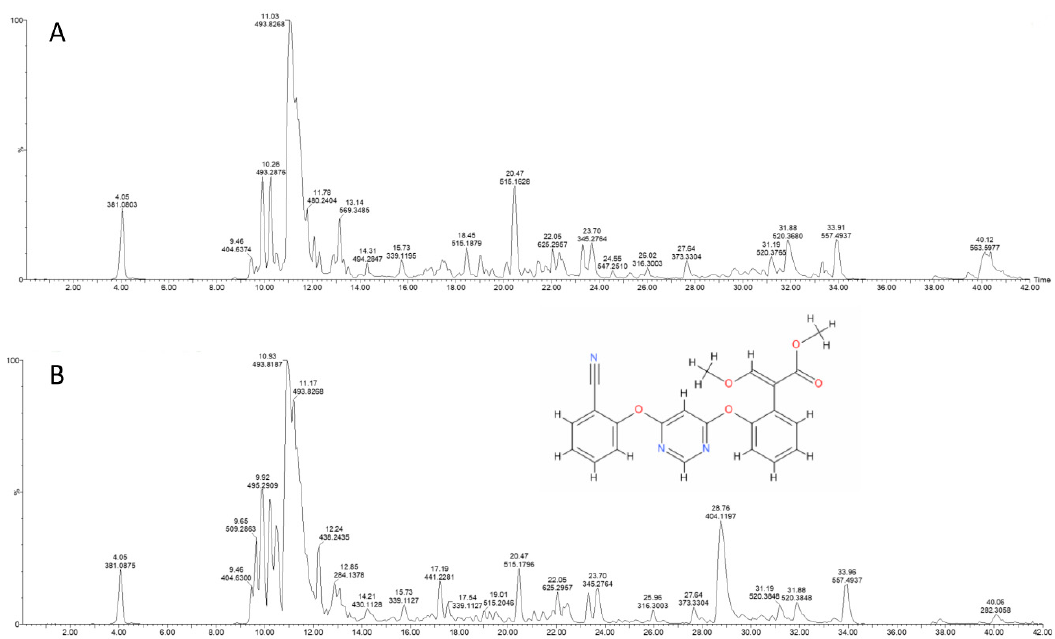
Figure 1. Q-TOF survey profile of the total metabolites extracted from maize root in control (panel A ) and azoxystrobin treated ones (Panel B ). Untargeted MS of roots methanol extracts at 96h has revealed the presence of a differential peak occurring at about 28.5 min with 404.1197 as m/z which is correspond to MH+ of azoxystrobin (exact mass, 403.1168; IUPAC Name, methyl ( E )-2-[2-[6-(2-cyanophenoxy)pyrimidin-4-yl]oxyphenyl]-3-methoxy-prop-2-enoate). In the ordinate is shown the signal intensity in percentage; in the abscissa the retention time (RT) in minutes.